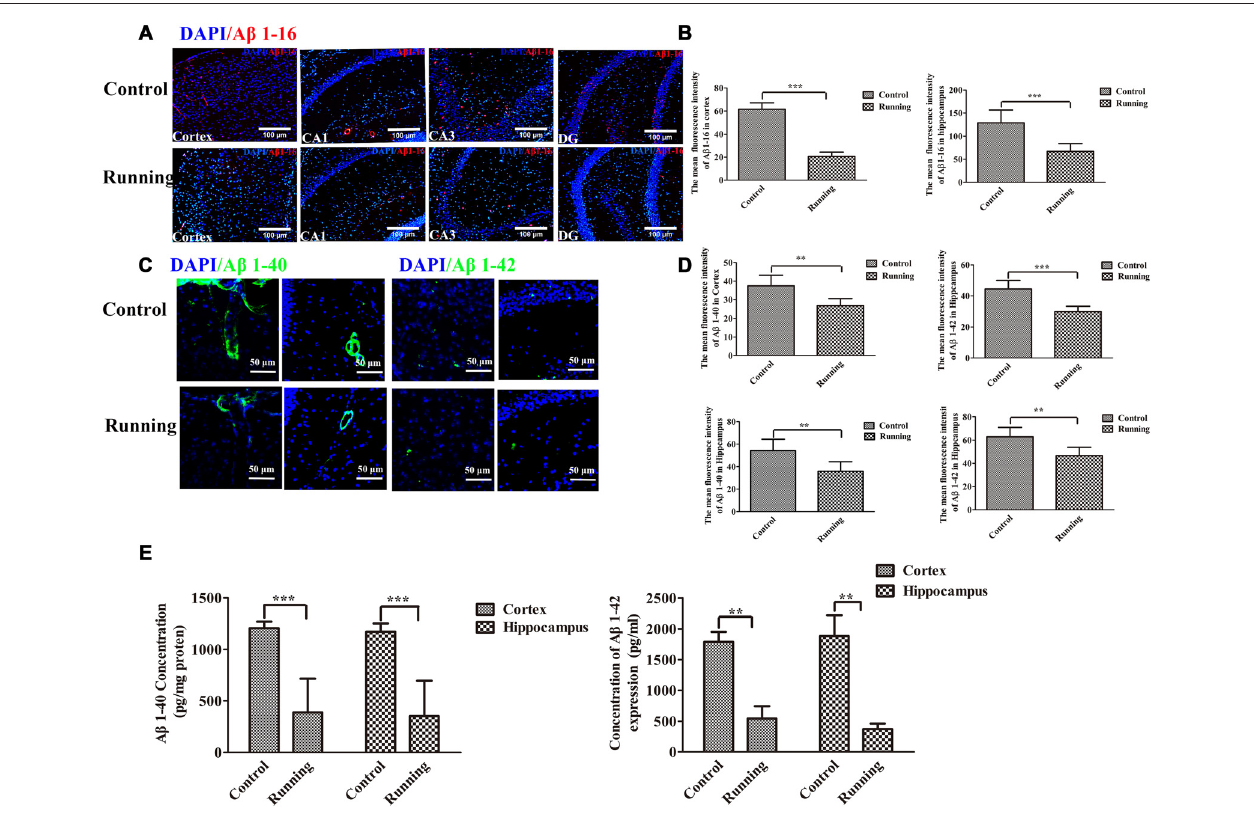
FIGURE 6 | Effect of voluntarily running on amyloid β accumulation. (A) Immunofluorescent staining of A β 1–16 in the control and running groups (200 × , scale bar = 100 µ m). (B) Histograms comparing the average A β 1–16 fluorescence intensity in the cortex and hippocampus in the control and running groups ( n = 6 per group). (C) Immunofluorescent staining of A β 1–40 and A β 1–42 in the control and running groups (250 × , zoomed in three-fold, scale bar = 50 µ m). (D) Histograms comparing the average A β 1–40 and A β 1–42 fluorescence intensity in the cortex and hippocampus in the control and running groups ( n = 6 per group). (E) Comparison of the A β 1–40 and A β 1–42 levels detected with enzyme-linked immunosorbent assays (ELISAs). Datasets are expressed as means ± SD, n = 6. ∗∗ P ≤ 0.01; ∗∗∗ P ≤ 0.001.